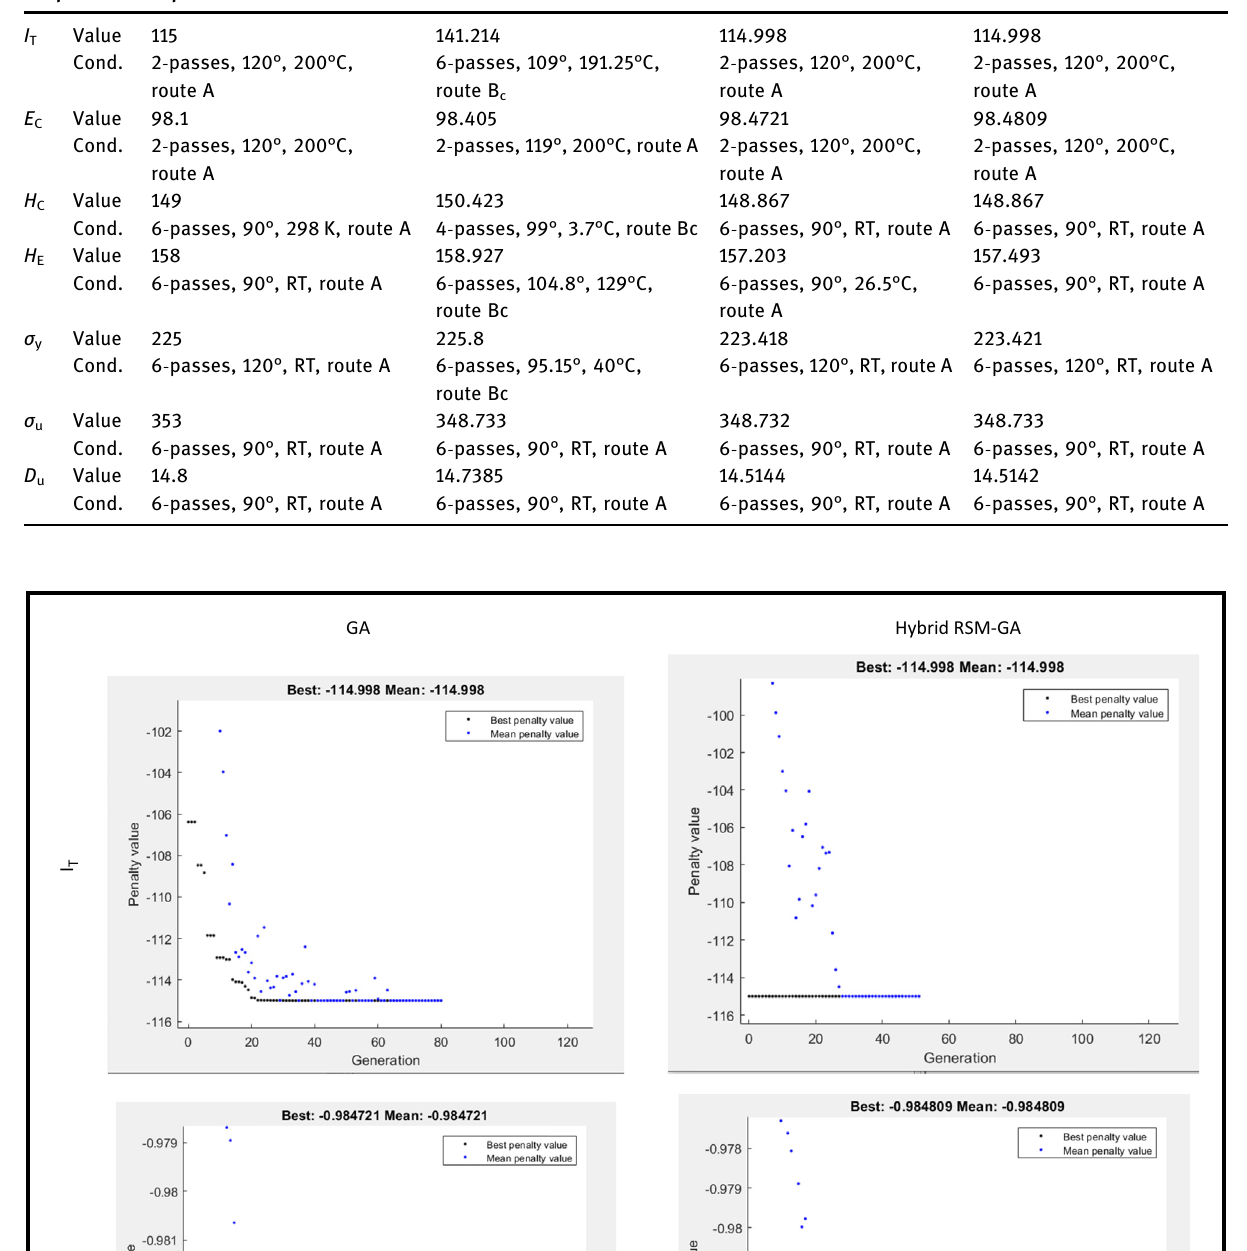
Table 4: Summary results of commercial pure copper ECAP process Response